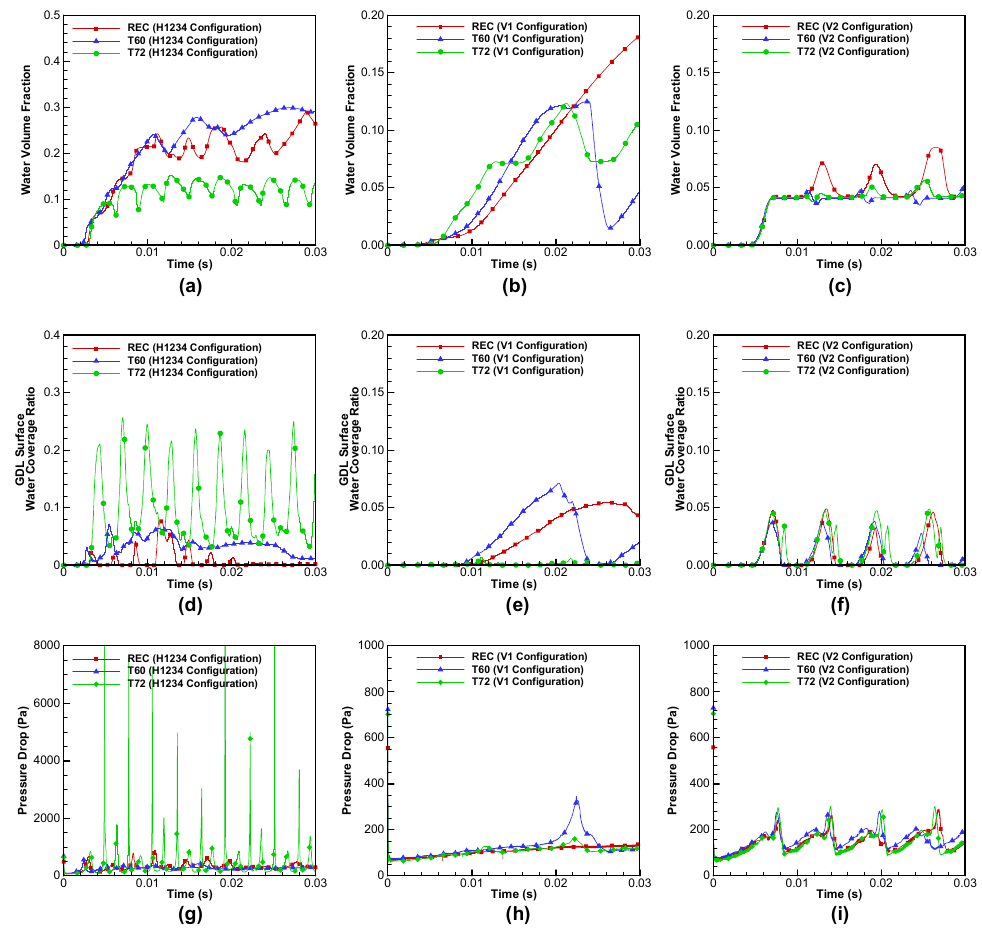
Figure 6. Effect of the GC cross-sectional shape on the time evolution of ( a ) WVF (H1234); ( b ) WVF (V1); ( c ) WVF (V2); ( d ) GWCR (H1234); ( e ) GWCR (V1); ( f ) GWCR (V2); ( g ) pressure drop (H1234); ( h ) pressure drop (V1); ( i ) pressure drop (V2) ( V in , air = 5.0 m · s − 1 , V in , water = 0.1 m · s − 1 , θ ts = 60 ◦ , θ g = 130 ◦